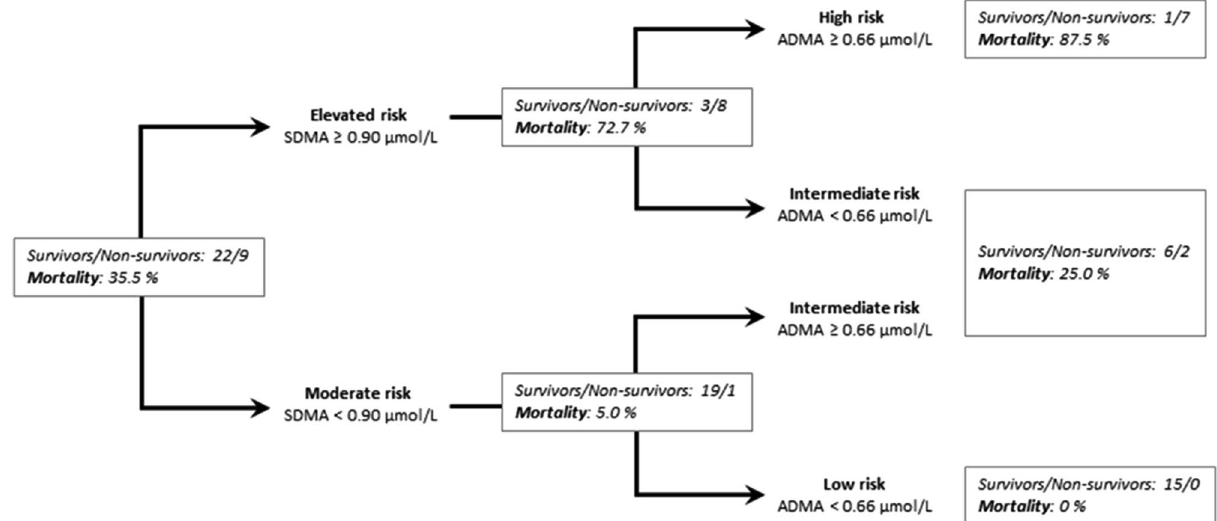
Figure 5. Decision tree analysis to identify the risk of in-hospital mortality. Out of 31 patients of whom serum samples were available for day 1, nine died (30%). First decision step: Patients were identified as having elevated risk when SDMA levels were ≥ 0.90 μmol/L, and moderate risk when SDMA levels were < 0.90 µmol/L. Second decision step: Additional analysis of ADMA allowed identification of patients with high risk (SDMA ≥ 0.90 µmol/L and ADMA ≥ 0.66 µmol/L (mortality, 87.5%), intermediate risk (SDMA ≥ 0.90 µmol/L or ADMA ≥ 0.66 µmol/L (mortality, 25%), or low risk (SDMA < 0.90 µmol/L and ADMA < 0.66 µmol/L (mortality,